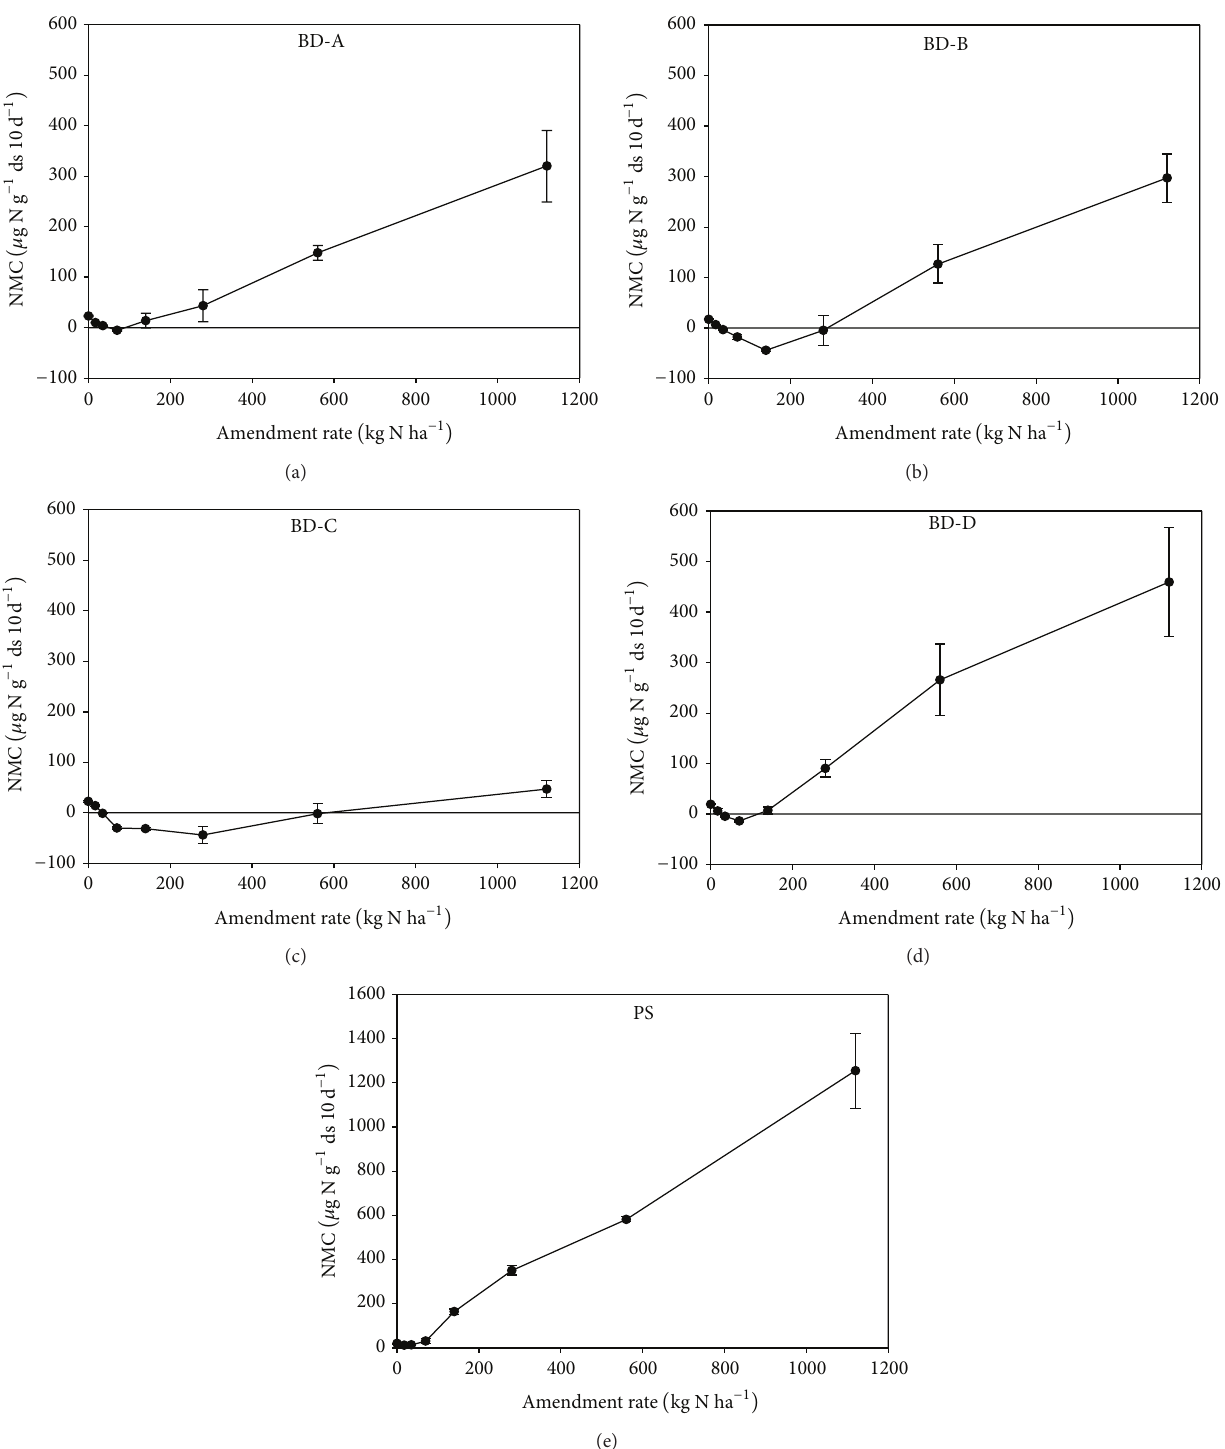
Figure 2: Dose-response test of nitrogen mineralization capacity (NMC) in the soil after amendment with different types of biogas residues (BD-A, BD-B, BD-C, and BD-D) and pig slurry (PS). Error bars represent mean values ± standard deviation ( 𝑛 = 3 ). Note the difference in the 𝑦 -axis scaling of